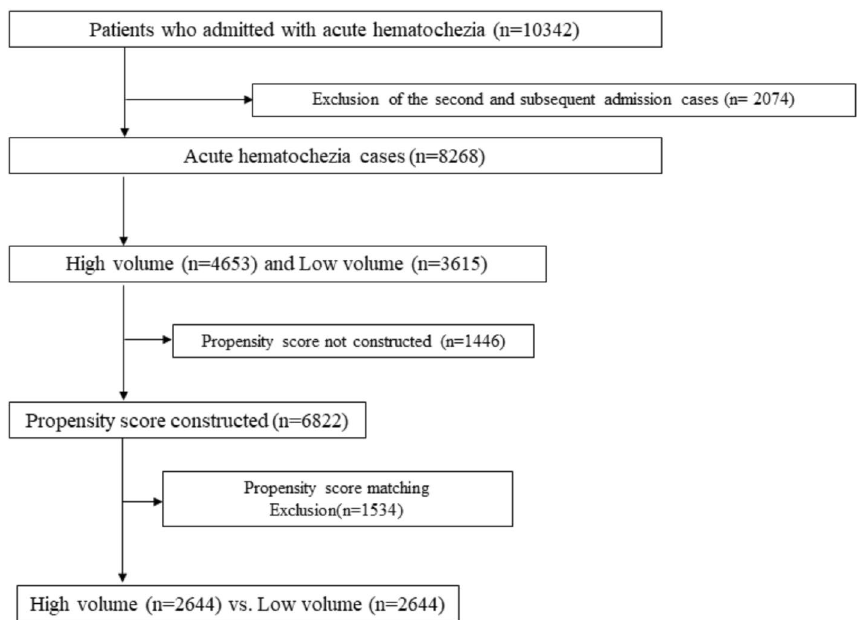
Figure 1. Study flow diagram of this study. Note A total of 10,343 patients were admitted due to acute hematochezia. Because one of the important outcomes was death within 30 days, the second and subsequent admission events were excluded to reduce selection bias, and the first admission cases were included in the study. A total of 8268 cases were divided into high- and low-volume groups. Propensity scores were constructed using complete data cases. A total of 2644 matched pairs were